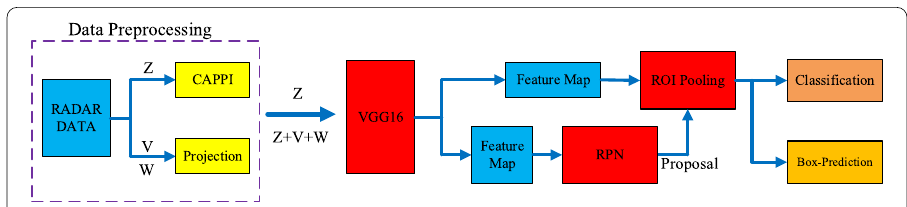
Fig. 7 The block diagram of precipitation clouds identification based on